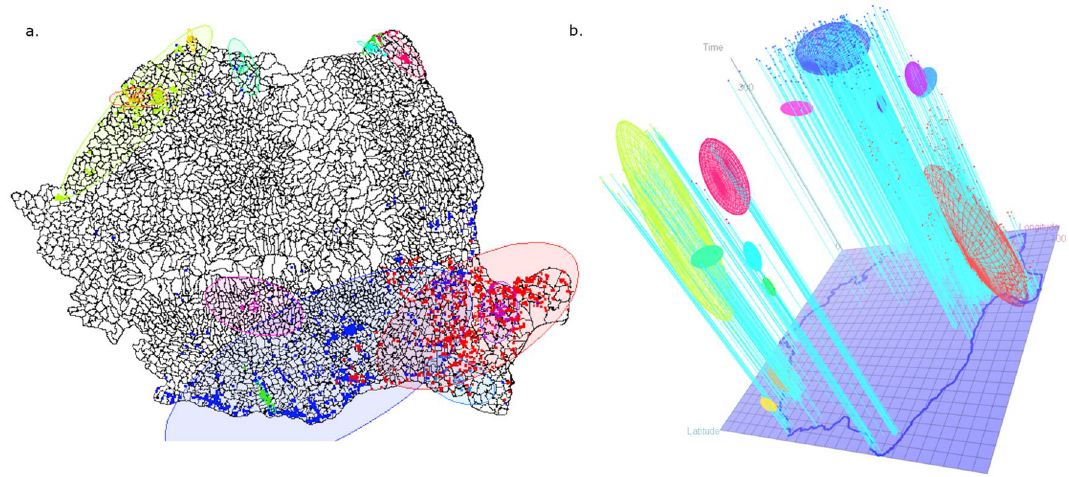
Figure 5. Geographic distribution of the 14 spatiotemporal clusters from June 10, 2018 to August 29, 2019 (N = 2973 cases; 2371 pig holding outbreaks and 602 wild boars cases). ( a ) 2-dimensional representation; ( b ) 3-dimensional plot, time being represented along the third (vertical) axis (interactive view available on